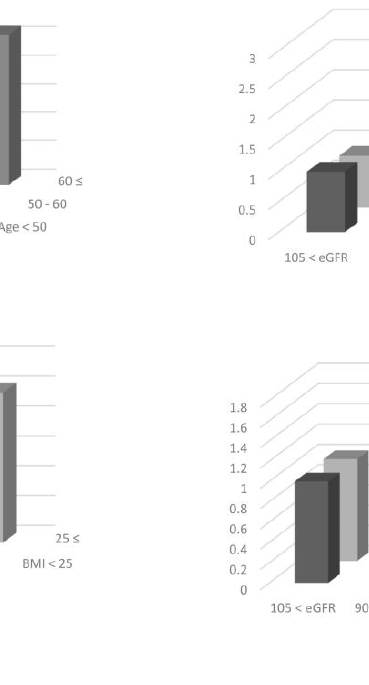
( f ) ( g ) Figure 3. Joint interaction of eGFR with potential confounders on incident metabolic syndrome. Plots show HR and p -values for interactions by eGFR category. ( a ) age, ( b ) gender, ( c ) BMI, ( d ) ex- ercise, ( e ) alcohol consumption, ( f ) smoking status, and ( g ) education. HR: hazard ratio; eGFR: esti- mated glomerular filtration rate; BMI: body mass index; MET: metabolic equivalent of task. 4. Discussion The present study indicates that even a small decline in the eGFR range of partici- pants with a normal eGFR range of ≥ 90 mL/min/1.73 m 2 was a risk factor for the develop- ment of MS in the 14-year longitudinal analysis. This risk also shows significant increasing trends as the eGFR declined. Furthermore, all covariates such as age, sex, BMI, exercise, alcohol consumption, smoking status, and education showed a significant joint effect with